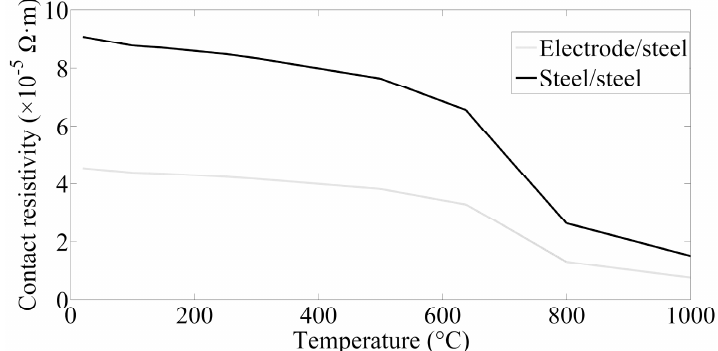
Figure 8. Contact resistivity (F = 3.5 kN).